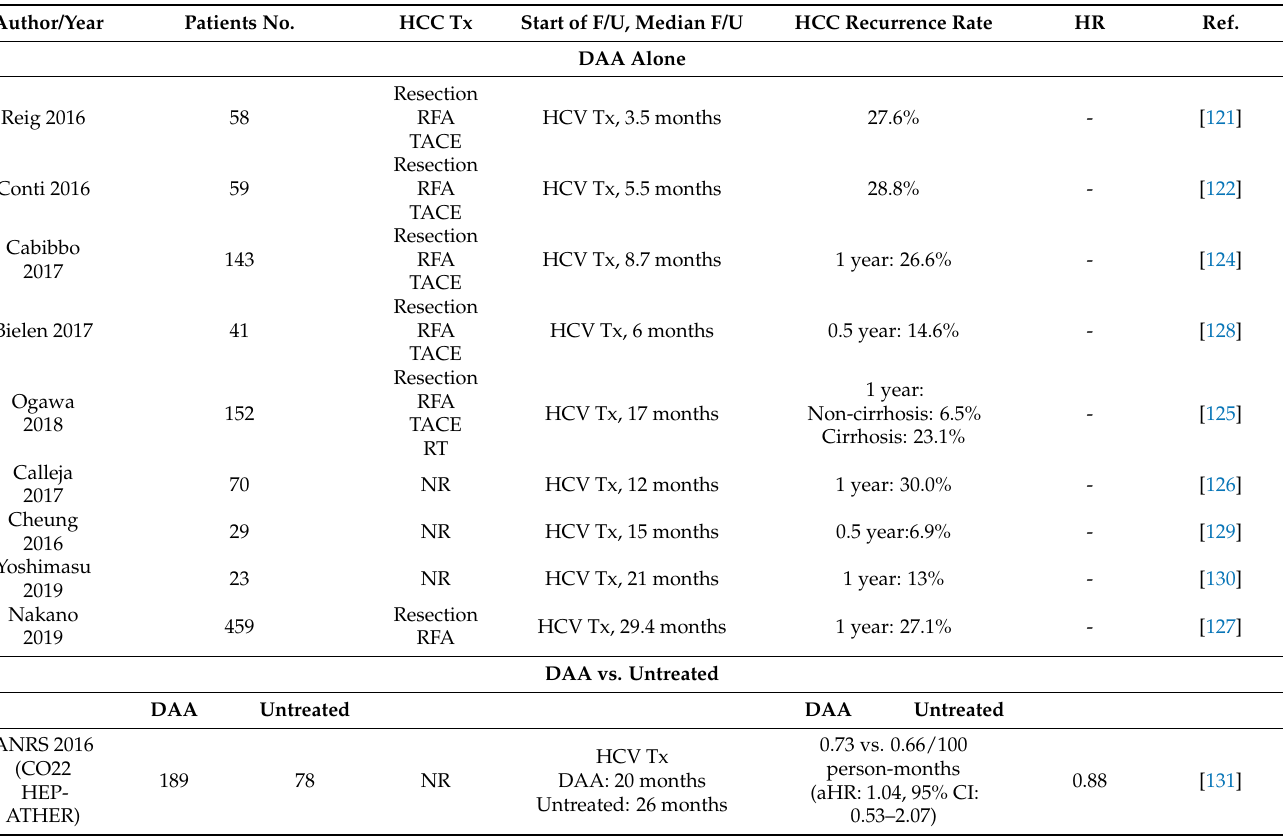
Table 2. Characteristics of studies reporting HCC recurrence rates after anti-viral therapy in chronic hepatitis C